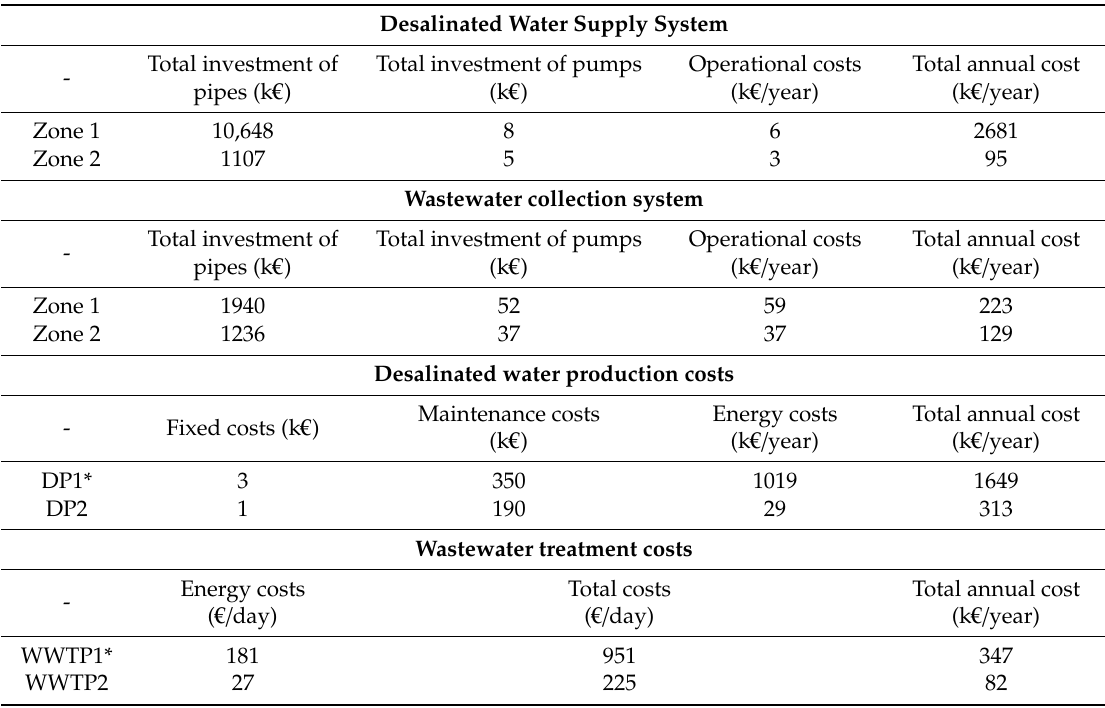
Table 4. Cost of the water supply